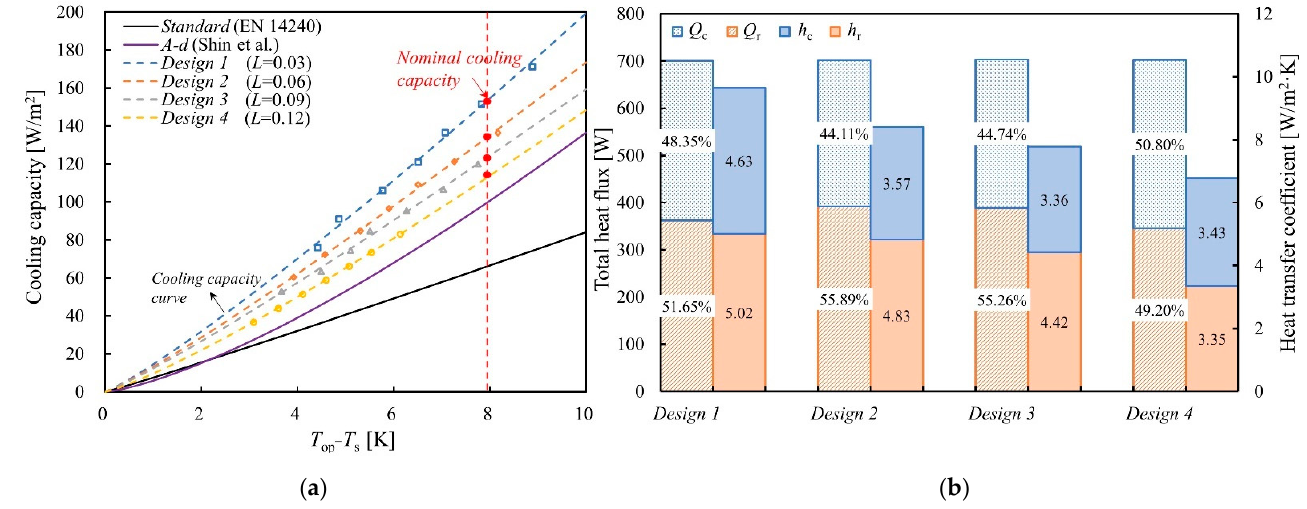
Figure 6. Comparison of different panel curvature lengths ( a ), cooling capacity curves [27,32] ( b ), and thermal performances under a cooling load of 1405.02 W.